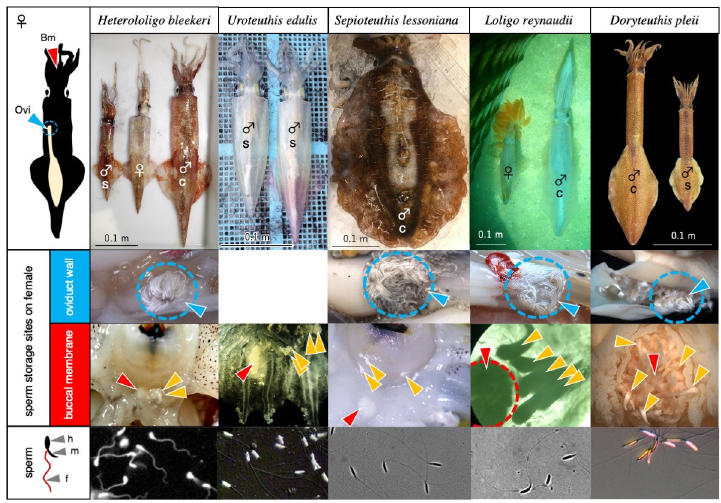
Fig 1. Comparative anatomy of female’s sperm storage sites in squids. Top row, a diagram of female’s sperm storage sites, i.e., on the oviduct wall (Ovi) and buccal membrane (Bm), and five species in the family Loliginidae used in this study. Second and third rows, the spermatangia attached to the oviduct wall ( blue arrowheads) and buccal membrane ( yellow arrowheads). The seminal receptacle ( red arrowhead) is located on the buccal membrane. Bottom row, representative images of spermatozoa retrieved from the spermatangia. Photographs from the oviduct wall and buccal membrane of D . pleii were originally published in [30] and are reproduced here with permission. s, sneaker; c, consort; h, head; m, midpiece enriched with mitochondria; f,